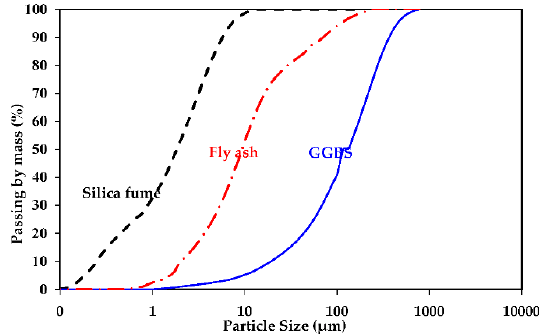
Figure 1. Particle size distributions of ASMs.